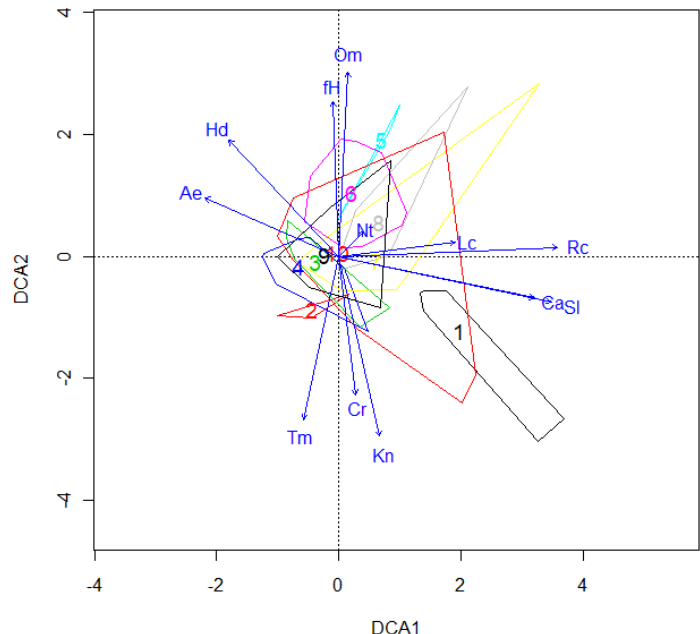
Fig. 13. Results of the ordination analysis of syntaxa in the class